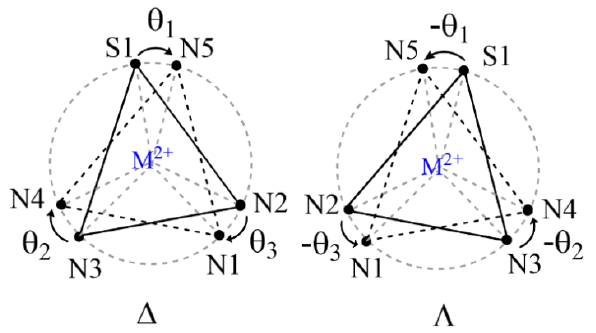
Figure 3. A representation of the torsion angles defined by the two trigonal planes. A positive torsion angle indicates the ∆ enantiomer, and a negative torsion value indicates the Λ enantiomer. A trigonal prismatic geometry is indicated by a torsion angle of 0 ◦ , whereas a torsion angle of 60 ◦ indicates an octahedral geometry. The average torsion angles within the complexes are shown in Table 3. Interestingly, [Mn1H L ] + and [Zn1H L ] + exist as the ∆ ( δ , δ , δ , δ ) and Λ ( λ , λ , λ , λ ) enantiomers, and [Mn2H L ] + and [Zn2H L ] + exist as the ∆ ( λ , λ , λ , λ ) and Λ ( δ , δ , δ , δ ) enantiomers. Table 3. The dihedral angles between the two trigonal planes in the [Mn1H L ] + , [Mn2H L ] + , [Co1H L ] + , [Co2H L ] + , [Zn1H L ] + and [Zn2H L ] + metal centres.